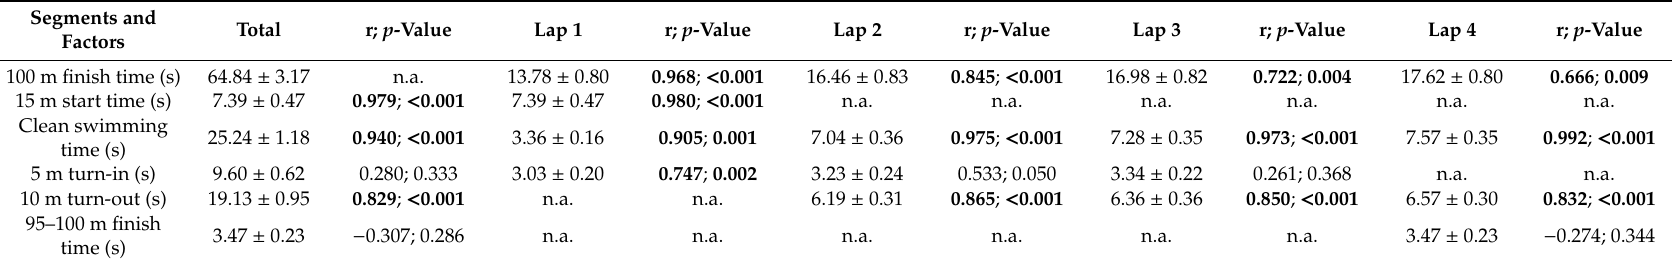
Table 2. Descriptive statistics (mean ± standard deviation) and partial correlation analysis of final performance time, start, turn, swim and finish segments with underlying components.